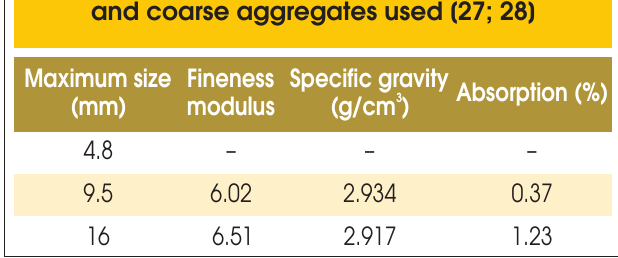
Table 5 – Physicochemical characteristics